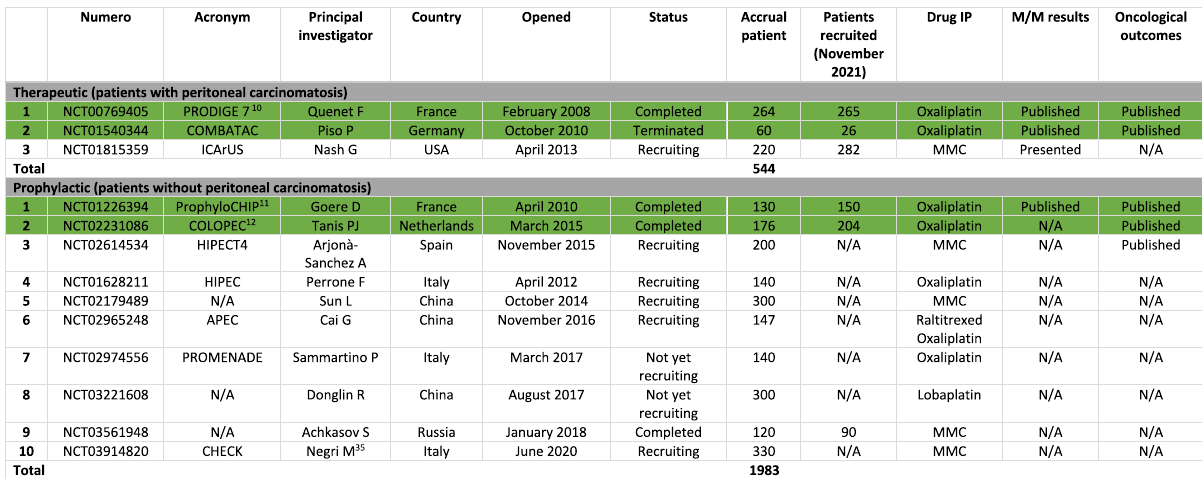
Table  : Prospective randomized trials evaluating CRS and HIPEC in colorectal cancer.